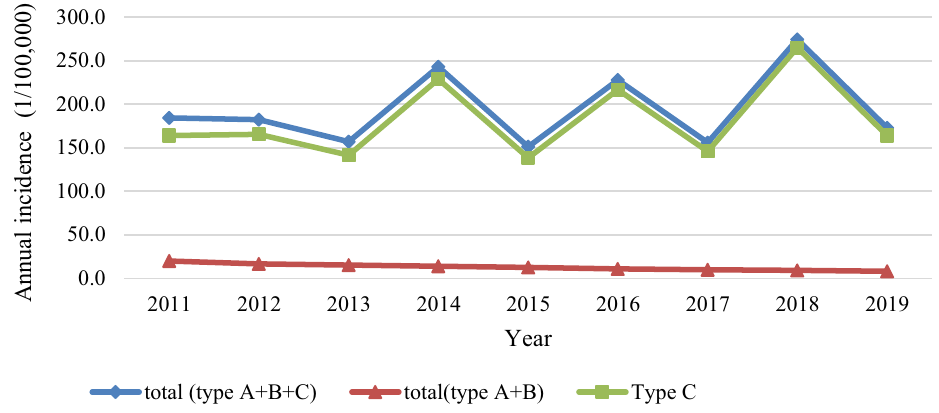
Figure 1. Variation trends in three types of intestinal infectious diseases in Jiangsu Province during